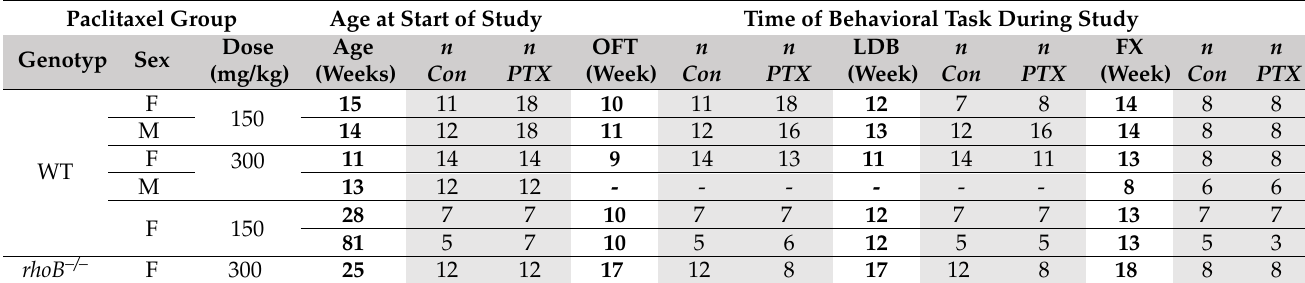
Table 1. Behavior Testing Timeline. WT = Wild Type animal, rhoB –/– = rhoB deficient animals, F = female, M = male, PTX = paclitaxel, OFT = Open Field Testing, LDB = Light Dark Box, and FX = Fear Extinction. Paclitaxel